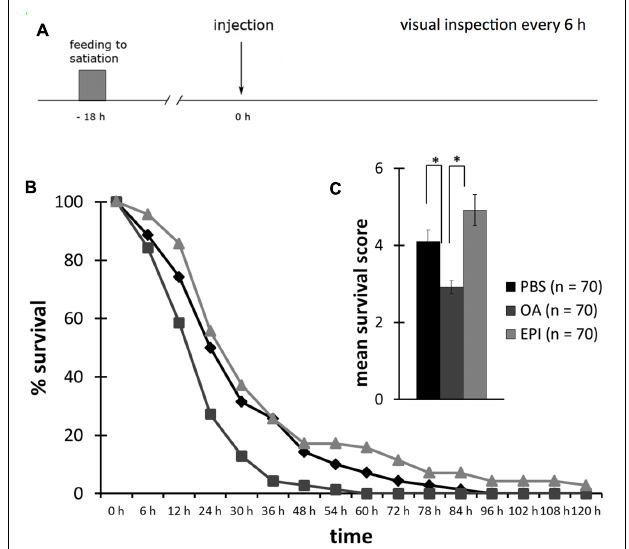
FIGURE 4 | Reduced survival following octopamine-treatment of hungry honeybees. (A) Schematic overview of the experiment. Bees were fed to satiation with 30% (w/v) sucrose solution (0.88 M) 18 h before injection of octopamine (OA), epinastine (EPI), or PBS. Their survival was observed every 6 h. (B) Survival of bees injected with PBS (rhomb, black), OA (square, dark gray), or EPI (triangle, light gray). (C) Bees injected with OA had a significant lower survival score than bees injected with PBS or EPI. ∗ p < 0.05. Number of bees appears in